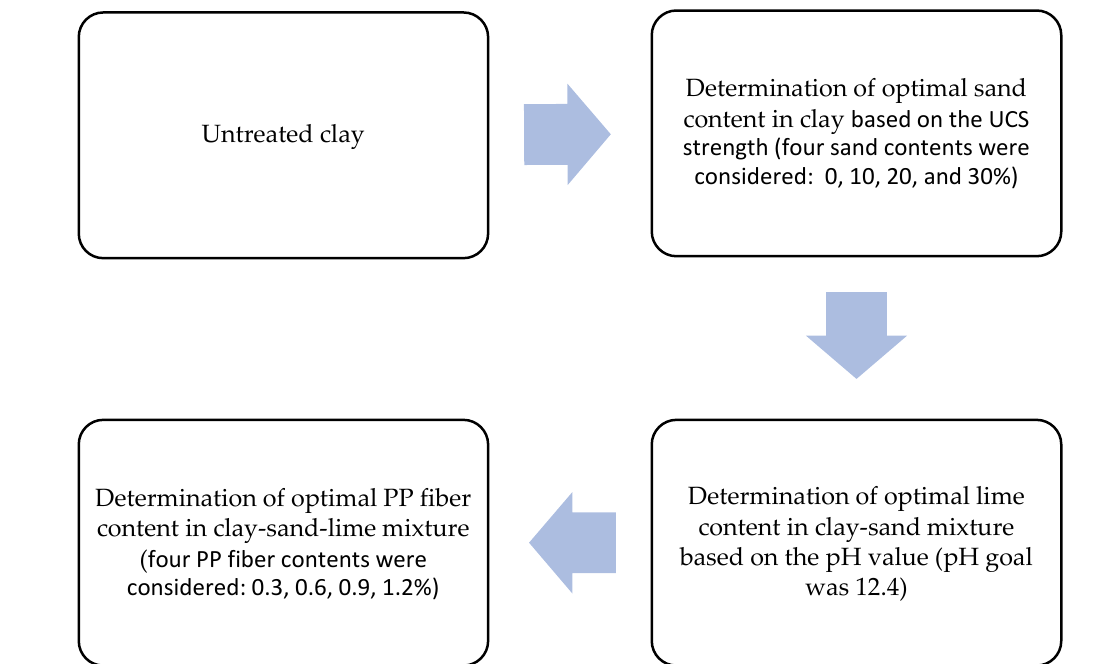
Figure 3. Flow chart of the procedure followed to optimize additives used.